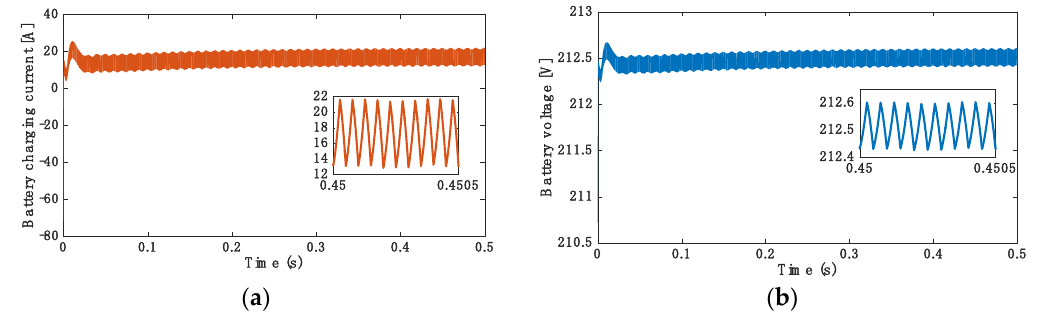
Figure 14. G2V: ( a ) Battery charging current; ( b ) Battery voltage.